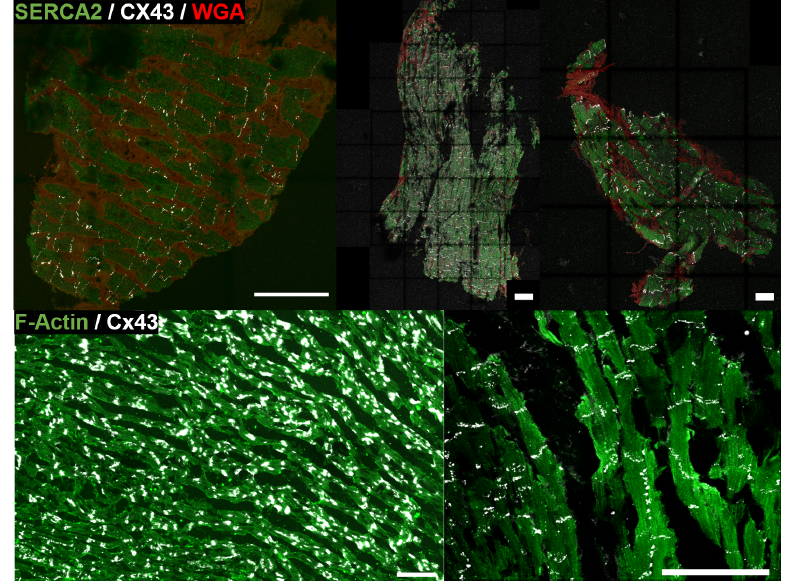
Figure 1. Input fluorescence microscopy images. A , B , C , from left to right: human samples from three individuals a , b and c . D and E , from left to right: rat samples d 2 and e . Green signal corresponds to sarco/endoplasmic reticulum Ca 2 + ATPase (SERCA2) in humans and F-actin in rat samples (channel c 1 ). White signal marks connexin 43 (CX43) (channel c 2 ). Red signal is wheat germ agglutinin (WGA) in human samples (channel c 3 ). Scale bar is in all cases 100 µ